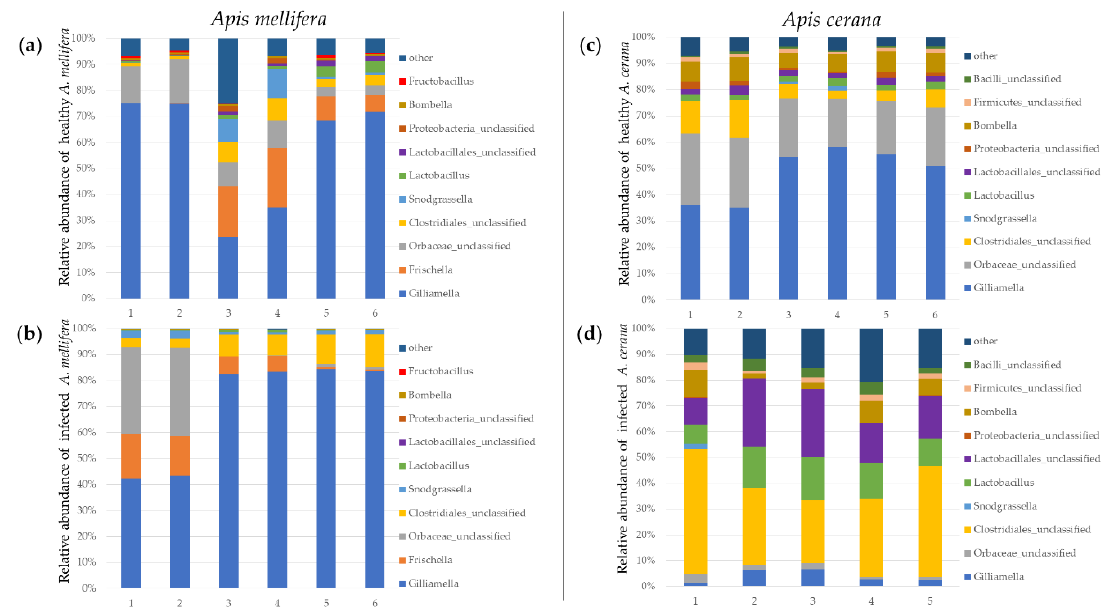
Figure 2. Proportions of bacterial communities found in control bees ( a , c ) and SBV-infected larval bees ( b , d ) of A. mellifera ( a , b ) and A. cerana ( c , d